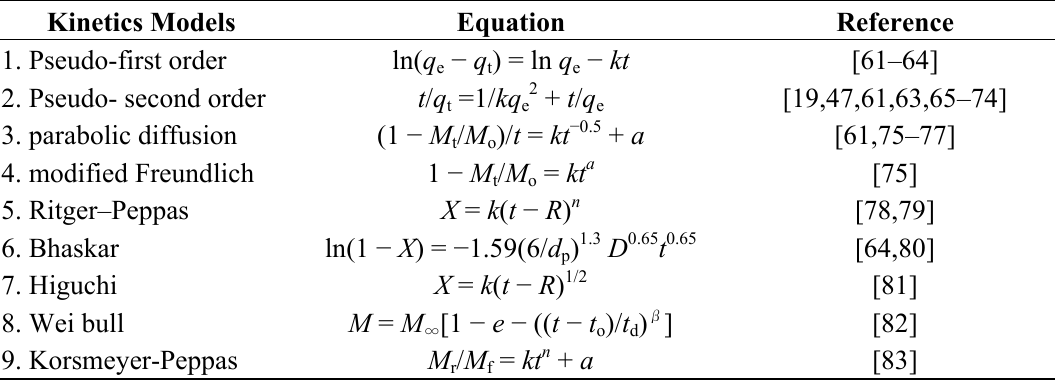
Table 2. Equations used for fitting controlled release profiles of